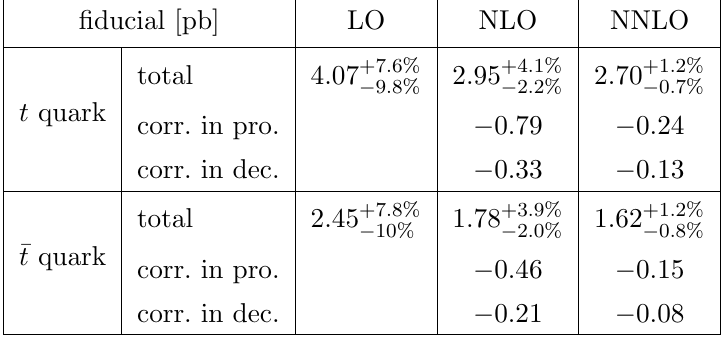
Table 2 . Fiducial cross sections for top (anti-)quark production with decay at 13 TeV at various orders in QCD with a central scale choice of m in both production and decay. The scale uncer- t tainties correspond to a quadratic sum of variations from scales in production and decay, and are shown in percentages. Corrections from purely production and purely decay are also